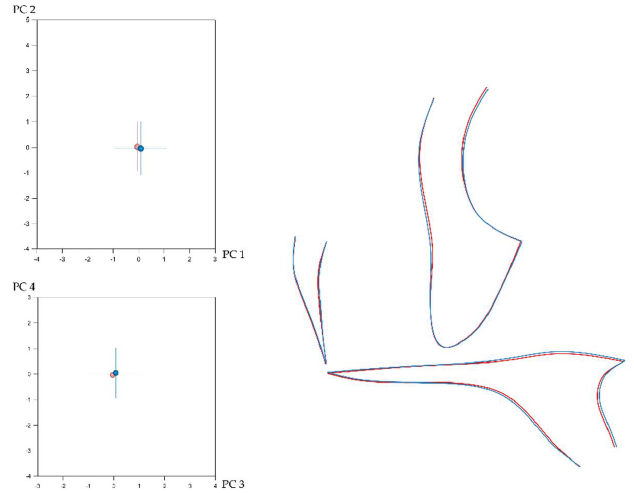
Figure 5. Left : Average difference between males (blue) and females (light red) in maxillary shape as explained by PC1 (21.3%)–PC2 (15.6%) ( top ) and PC3 (11.1%)–PC4 (7.7%) ( bottom ). The numbers in the parentheses represent the percentage of variation explained by each PC. Right : Best fit superimposition of average male (blue) and average female (light red) maxillary configurations.